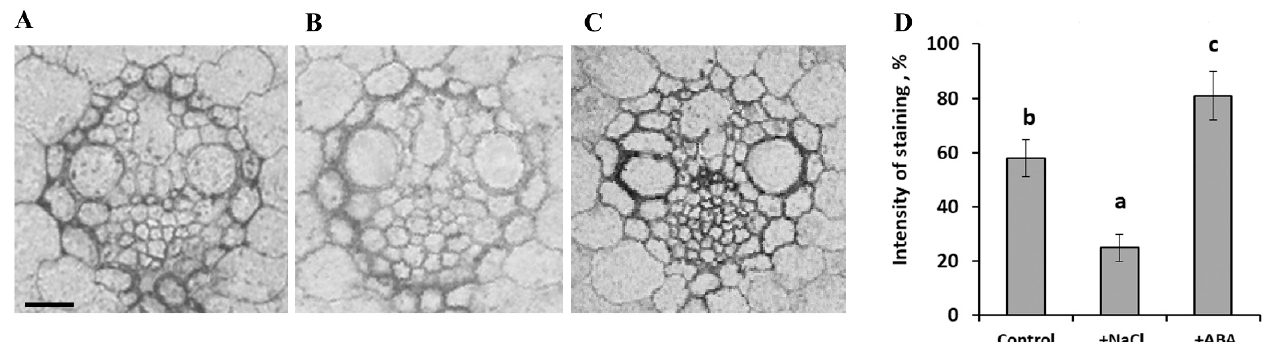
Figure 3. Immunohistochemical localization of HvPIP2;2 in the vasculature of leaves of the control ( A ), salt- ( B ), and ABA-treated ( C ) barley plants and semiquantitative estimation of the staining for HvPIP2;2 of vasculature cells ( D ). Statistically different values (n = 20) are labeled with different letters (Duncan test, p < 0.05). Scale 25 µm.